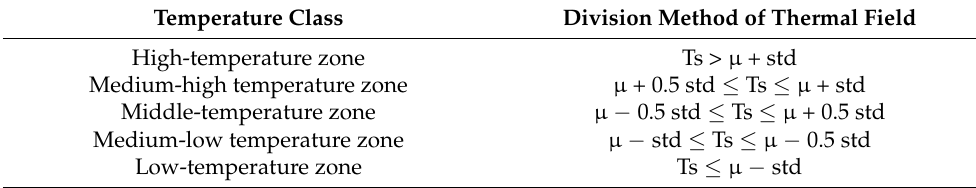
Table 1. Division method of the mean-standard deviation thermal